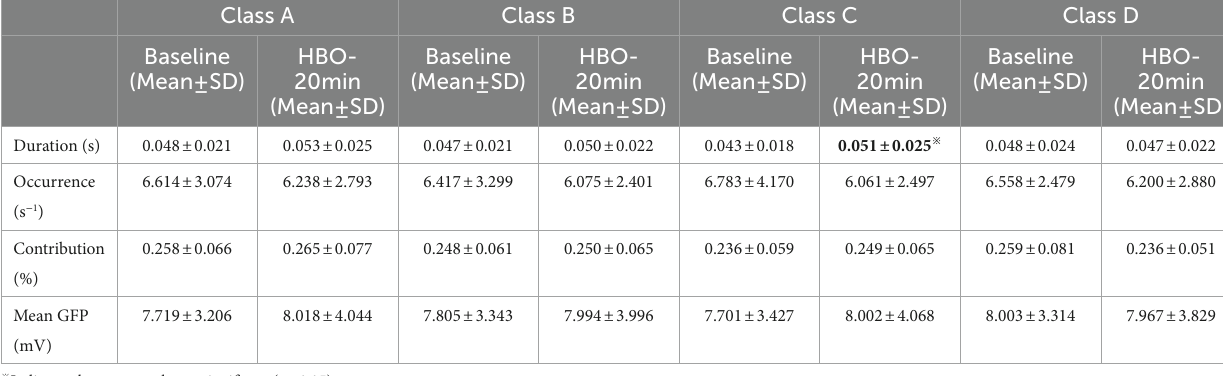
※ Indicates the t -test result was significant ( p < 0.05). The duration of microstate C in 41 patients was significantly increased after 20 min of HBO therapy compared with the corresponding pretreatment duration ( p < 0.05). Other microstate parameters did not change